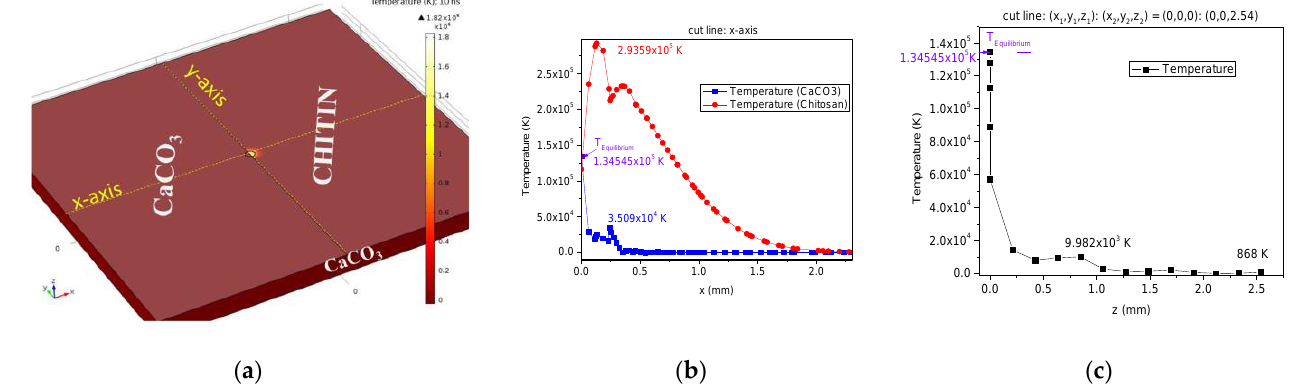
Figure 2. COMSOL simulation of laser-irradiated nonhomogeneous target with CaCO 3 and chitin components: target components and temperature (K) developed on its surface 10 ns after laser pulse ignition ( a ); phase change diagram T(x), 10 ns after laser pulse ignition ( b ); phase change diagram T(z), 10 ns after laser pulse ignition ( c ).